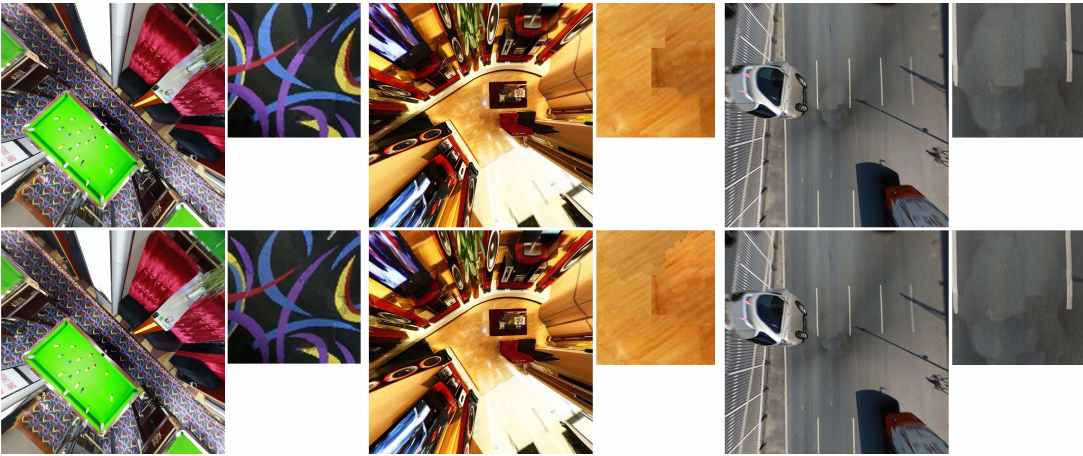
Figure 11. Comparative results without the luminance compensation in the top row and with it in the bottom